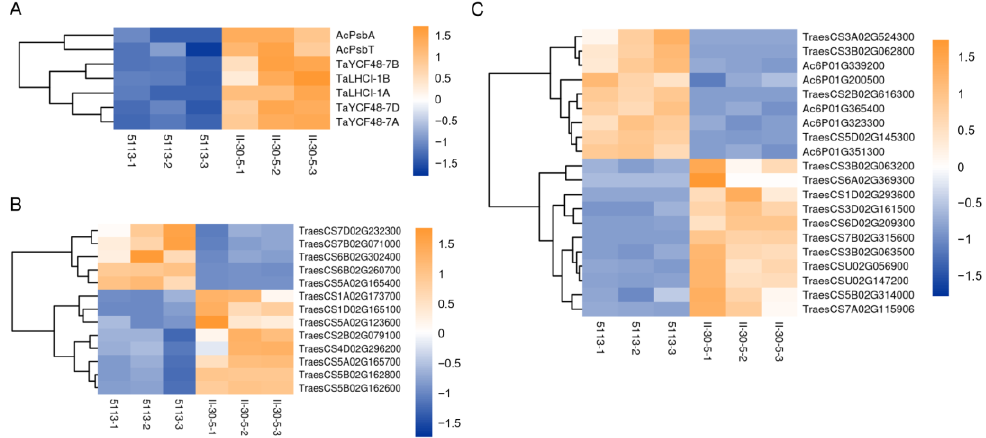
Figure 7. Heatmap of DEGs related to photosynthesis, carbon metabolism, and lipid metabolism between 5113 and II-30-5. ( A ) Differential expression of photosynthesis-related genes; ( B ) carbon- metabolism-related genes; ( C ) lipid-metabolism-related genes.